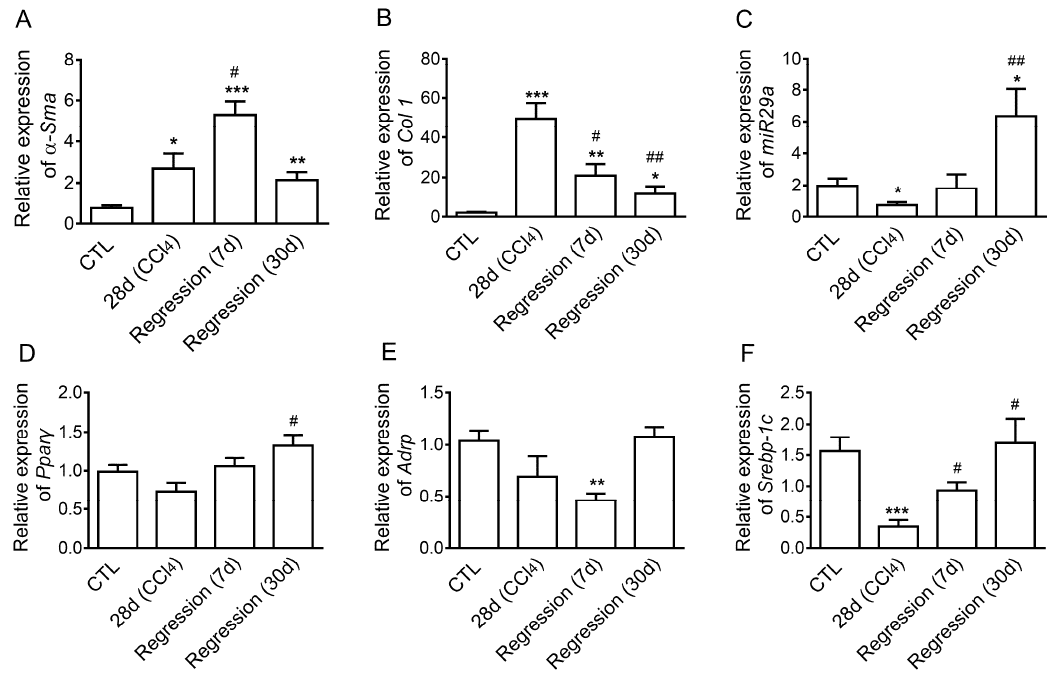
Figure 1. Expression of Mir29a and adipogenic-related genes expression increased, fibrogenic-related genes expression decreased in the resolution of liver fibrosis in mice. ( A – F ) Mice and littermate control mice were treated with oil or CCl 4 for 28 days, and liver tissues were harvested for the following analyses at the indicated time points. qRT-PCR analysis of α -Sma , Col1 , Mir29a , Ppar γ , Adrp , and Srebp-1c mRNA expression ( n = 5 per group). Error bar represents SEM. * p < 0.05, ** p < 0.01, and *** p < 0.001 vs. oil group. # p < 0.05, ## p < 0.01 vs. CCl 4 group.